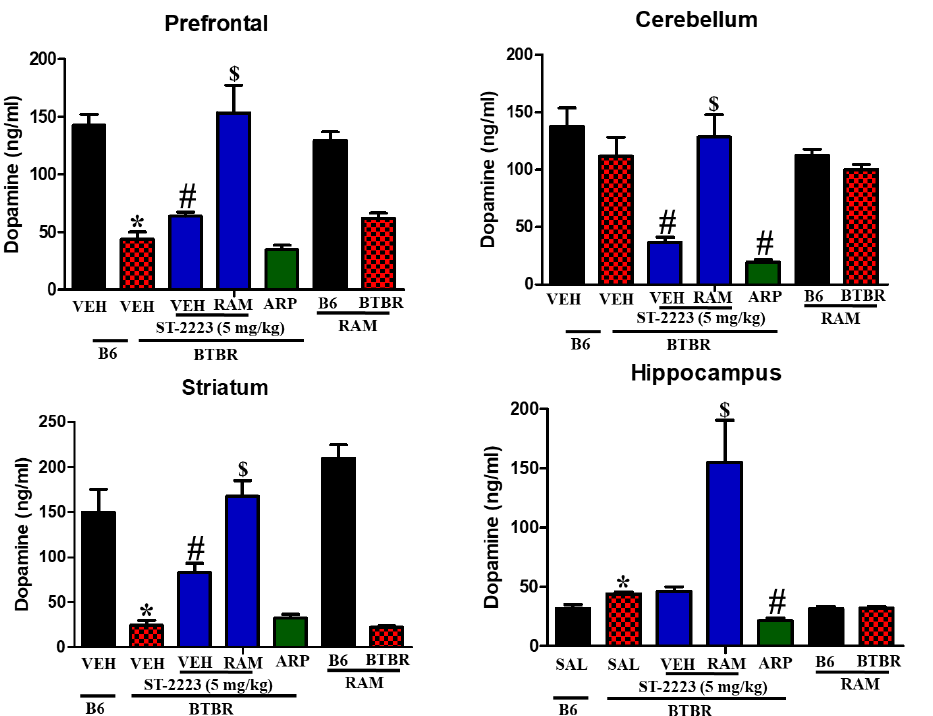
Figure 5. Estimation of dopamine levels by LC-MS/MS in different brain regions of BTBR * p < 0.05 compared to VEH-treated B6 mice. # p < 0.05 compared to VEH-treated BTBR mice. $ p < 0.05 compared to ST-2223-(5 mg)- treated BTBR mice. Data are expressed as the mean ± SEM (n = 5).